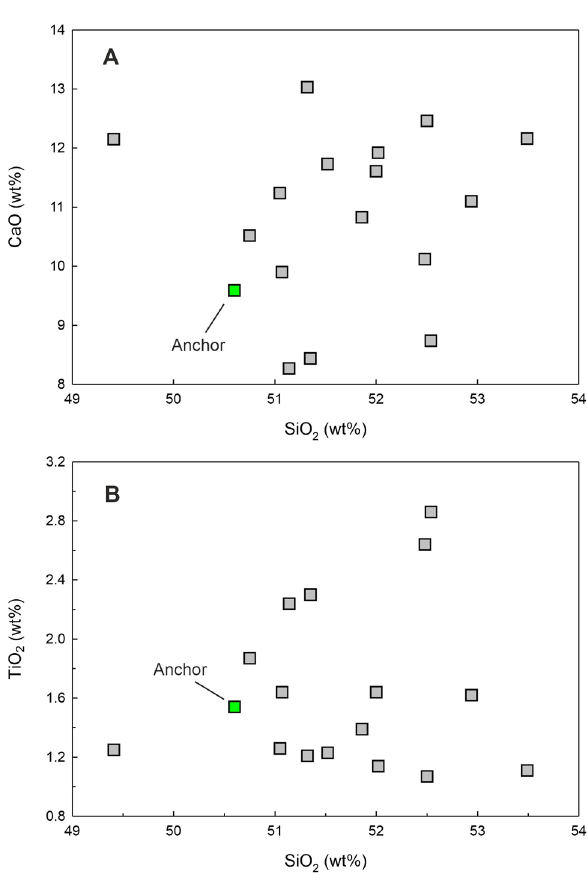
Figure 7. ( A ) CaO versus SiO 2 and ( B ) TiO 2 versus SiO 2 for the Chilika Anchor rock compared with the data for Palitana lava flows (data source: Sheth et al., 2013) 16